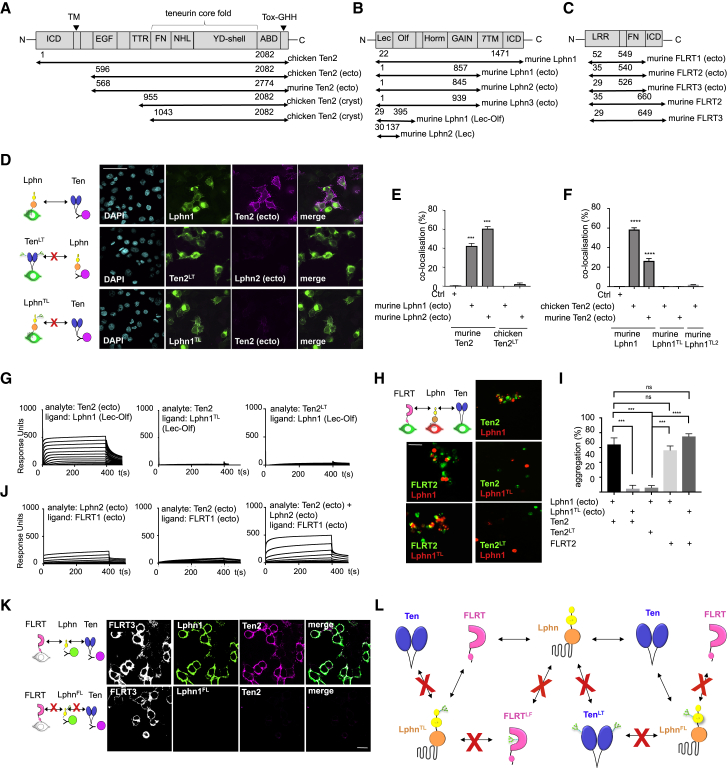
The Mutants TenLT and LphnTL Disrupt Teneurin-Latrophilin Binding(A–C) The Teneurin (Ten; A), Latrophilin (Lphn; B), and FLRT (C) constructs used in the study.(D) We tested receptor binding by expressing mVenus-tagged murine Lphn1 or chicken Ten2 (green) at the surface of HEK293 cells and detected the binding of His-tagged protein ectodomains (magenta) by immunofluorescence. DAPI labels cell nuclei (cyan). Representative images are shown.(E and F) Quantified results from the cell-based binding assays to test binding of surface expressed Ten with soluble Lphn (E), and surface expressed Lphn with soluble Ten (F). n = 12, ∗∗∗∗p < 0.0001, one-way ANOVA test with Tukey’s post hoc analysis.(G) In SPR experiments, we immobilized 220 response units of wild-type or mutant murine Lphn1 (Lec-Olf) on separate flow cells and injected Ten2 proteins using a 2-fold dilution series (highest concentration, 2.3 μM). Teneurin LT and Latrophilin TL mutants do not show binding.(H) K-562 cell aggregation assays show that the wild type, but not the mutants, promotes engagement of Latrophilin-expressing and Teneurin-expressing cells in trans. FLRT still interacts with LphnTL.(I) Quantified results from the cell aggregation assay. n = 3; ∗∗∗p < 0.001, ∗∗∗∗p < 0.0001, one-way ANOVA test with Tukey’s post hoc analysis.(J) In SPR experiments, we immobilized 440 response units of FLRT1 (ecto) on separate flow cells and injected chicken Teneurin and murine Latrophilin analytes using the same concentration series in each experiment (highest concentration, 660 nM). Injecting both Teneurin and Latrophilin over FLRT1 gave an increased response. These results suggest that a ternary Teneurin-Lphn-FLRT complex forms in vitro. Results using FLRT2 and FLRT3 are shown in Figure S2.(K) We tested binding of His-tagged Lphn1 (green) and Ten2 (magenta) ectodomains to HEK293 cells expressing FLRT3 (white). Only wild-type Lphn1, not the FL mutant, forms a ternary complex with FLRT and Teneurin at the cell surface.(L) A diagram summarizing the binding capabilities of wild-type and mutant proteins.Scale bars represent 50 μm (D and I) and 20 μm (K).